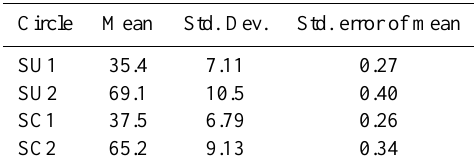
Table 3. Statistics for the PCASP-200 concentrations (#cm − 3 ) for sizes 0.14 to 2.75µm integrated for 1 s for the precipitation free periods 500 to 1200s of each circle.